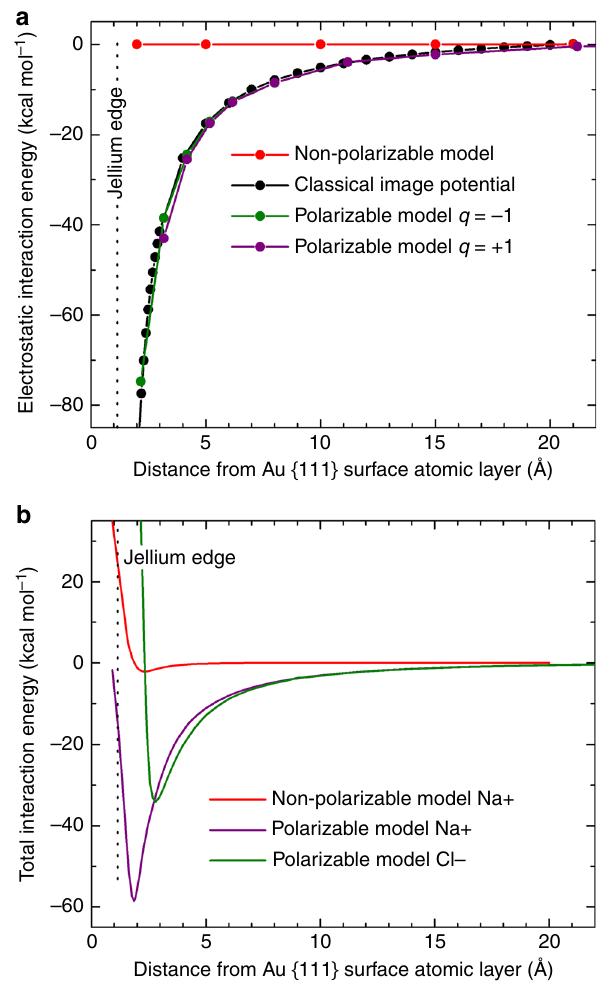
Fig. 2 Interaction of a positive charge (sodium ion) and a negative charge (chloride ion) with the metal surface in vacuum. a The electrostatic interaction energy as a function of distance from the surface using energy minimization. The polarizable model closely approximates the classical image potential and shows a large improvement over the non-polarizable Lennard – Jones potential. The curve remains the same for any cation or anion with a charge of + 1.0e or − 1.0e regardless of chemical identity. b The total energy of interaction of a sodium ion and a chloride ion with the Au (111) surface as a function of distance in molecular dynamics simulation at 298 K. Stable minima are seen near 1.86 Å and 2.81 Å distance from the surface atoms, respectively. The presence of Coulomb and Lennard – Jones interactions in the polarizable model imposes a barrier to dissolution in the metal of >50 kcal mol − 1 . The non-polarizable model does not reproduce the strong attraction. Computations involved 3D periodic simulation boxes and common Ewald summation of Coulomb interactions. A box size of at least 10 × 10 × 100 nm 3 is recommended to reduce errors in the computed image charge potential due to long-range interactions to